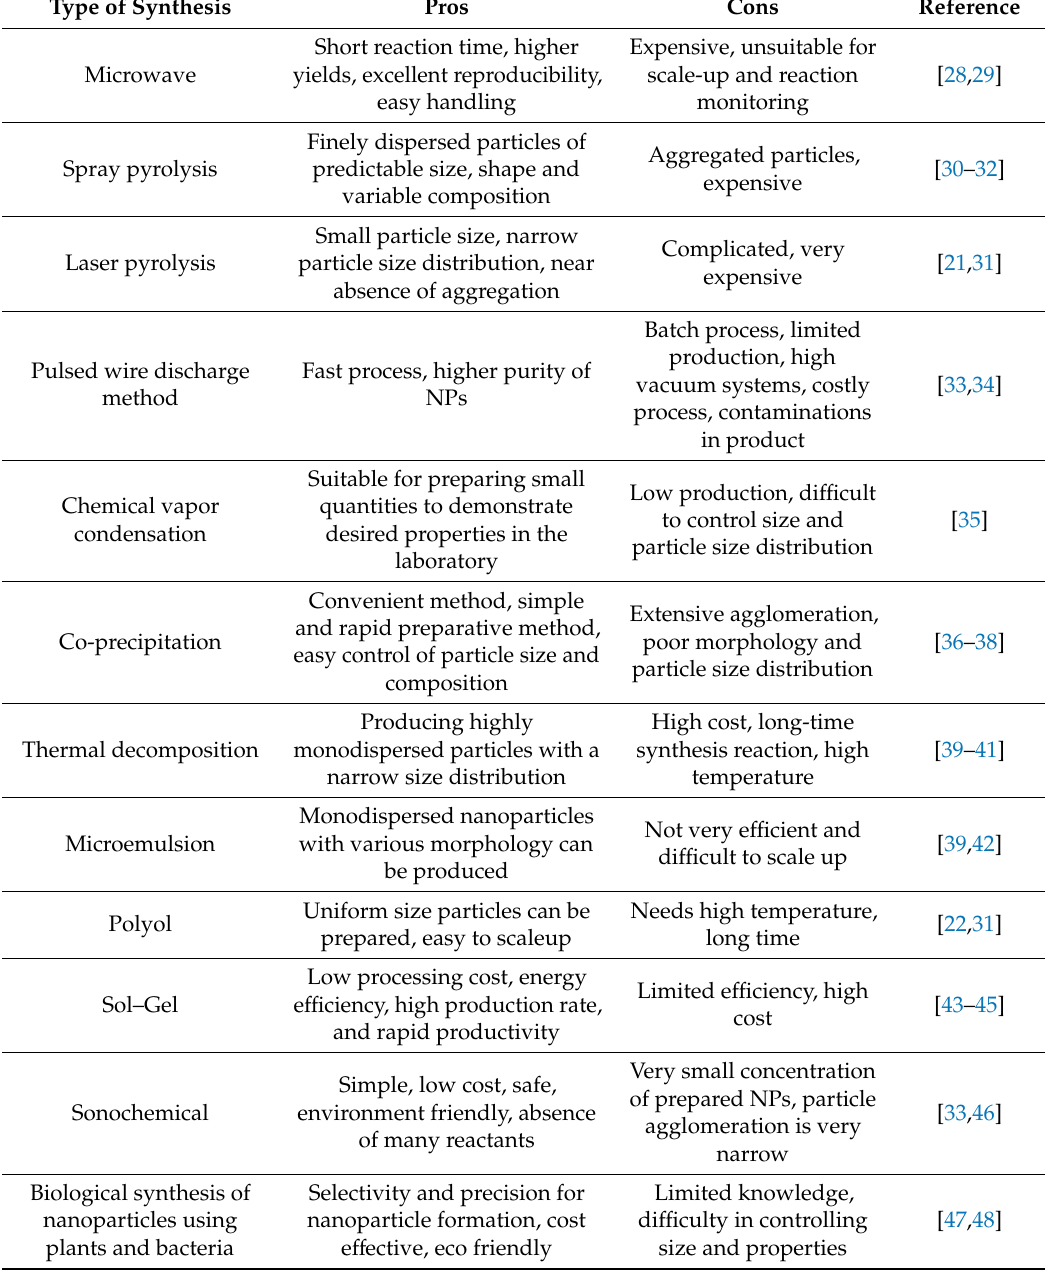
Table 1. Merits and demerits of di ff erent IONP nanoparticle synthesis